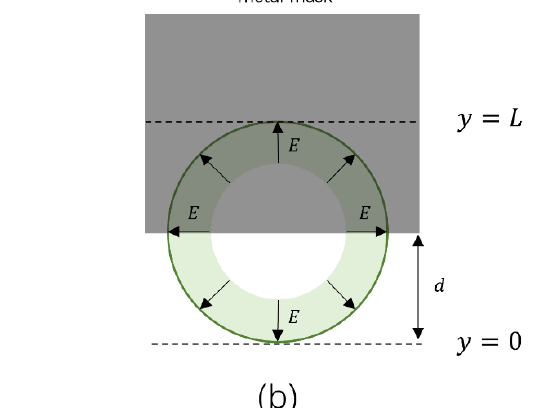
Figure 2. Side view ( a ), and front view ( b ), of the schematic diagram for beam shielding with a rectangular metal mask.